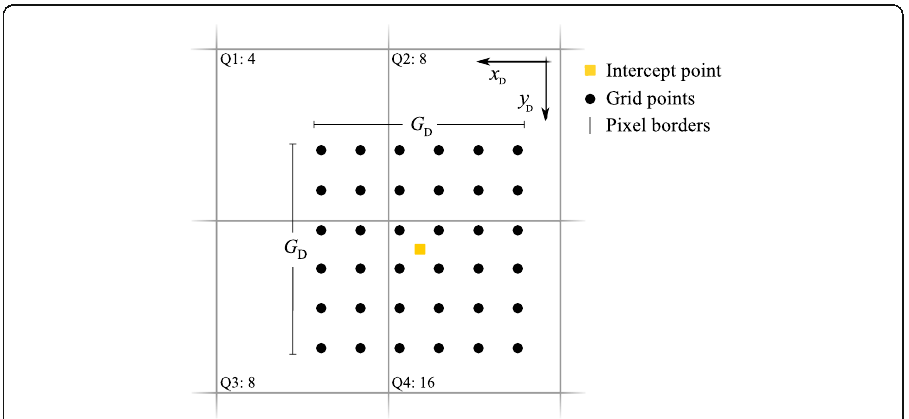
Fig. 1 Schematic representation of the N grid × N grid grid points (black dots) centred about the detector plane intercept point (yellow square). The grid is, in this case, distributed over four pixels (whose borders are represented by the grey lines), and the numbers of grid points in the respective pixels are 4, 8, 8, and 16 for quadrants 1, 2, 3, and 4 (Q1, Q2, Q3, and Q4), respectively. The signal contribution to a voxel from a specific pixel is the product of the pixel value and a normalization factor, that is, the number of grid points in the pixel divided by the total number of grid points in all of the detectors for the current